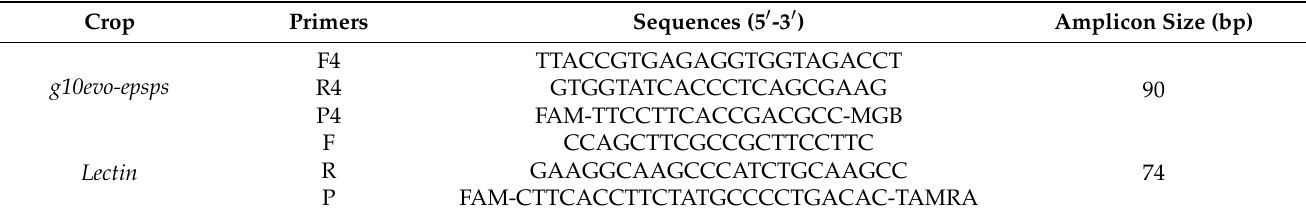
Table 2. Primers and probes used for the ZUTS-33 soybean